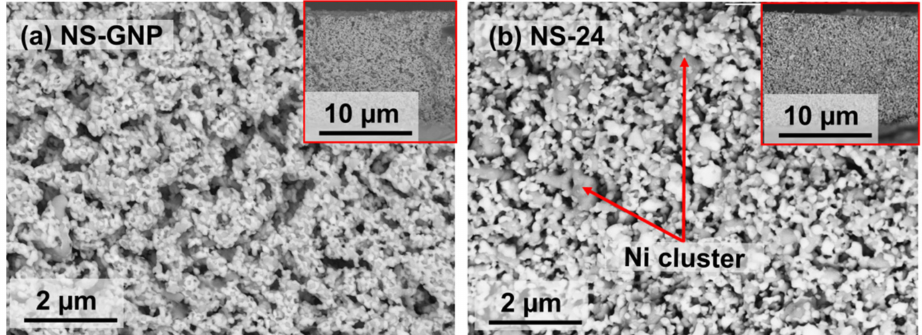
Figure 10. Cross-sectional images of the symmetrical cells: ( a ) NS-GNP and ( b )